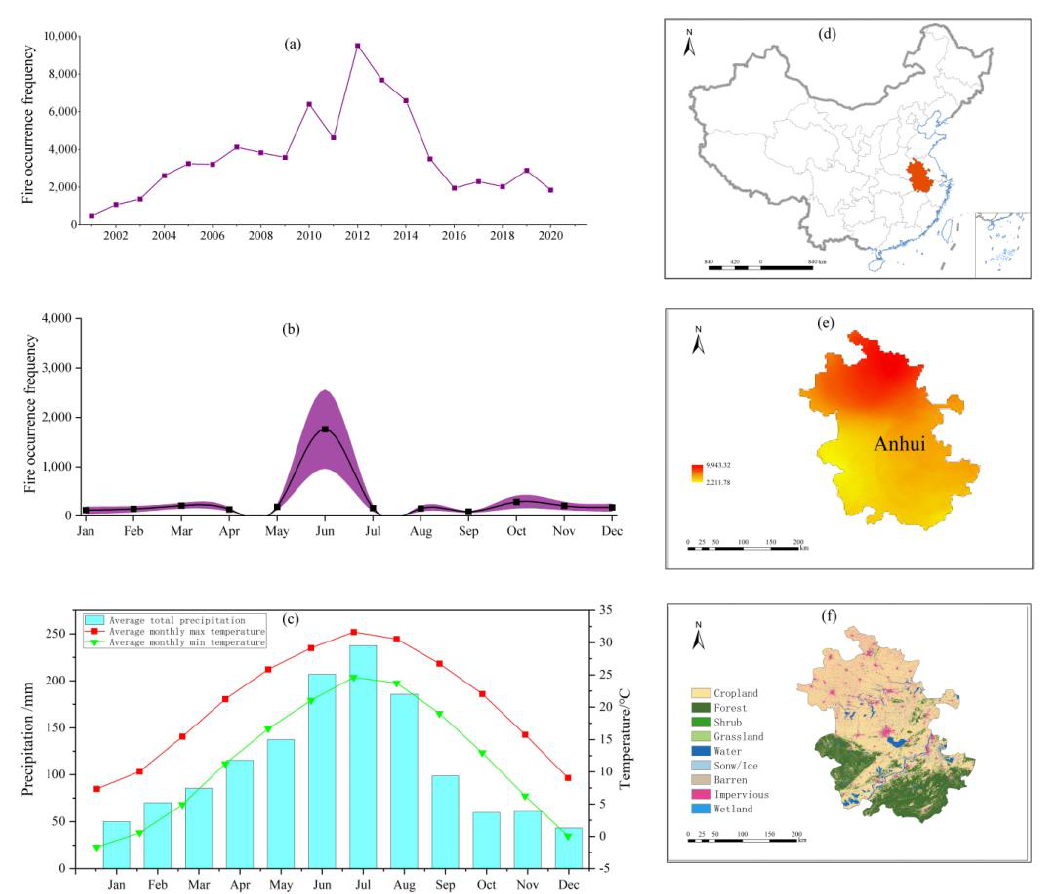
Figure 7. The total ( a ) occurrence frequencies of active fires over the study period, ( b ) monthly average number of active fire occurrence frequencies and their 95% confidence intervals (purple area), ( c ) average rainfall and temperature, ( d ) geographical position of Anhui in China, ( e ) spatial